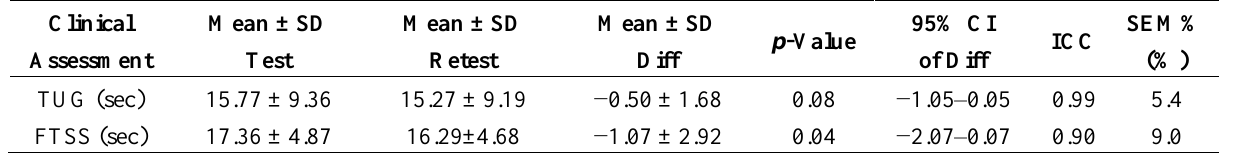
Table 1. Test-retest reliability of the clinical